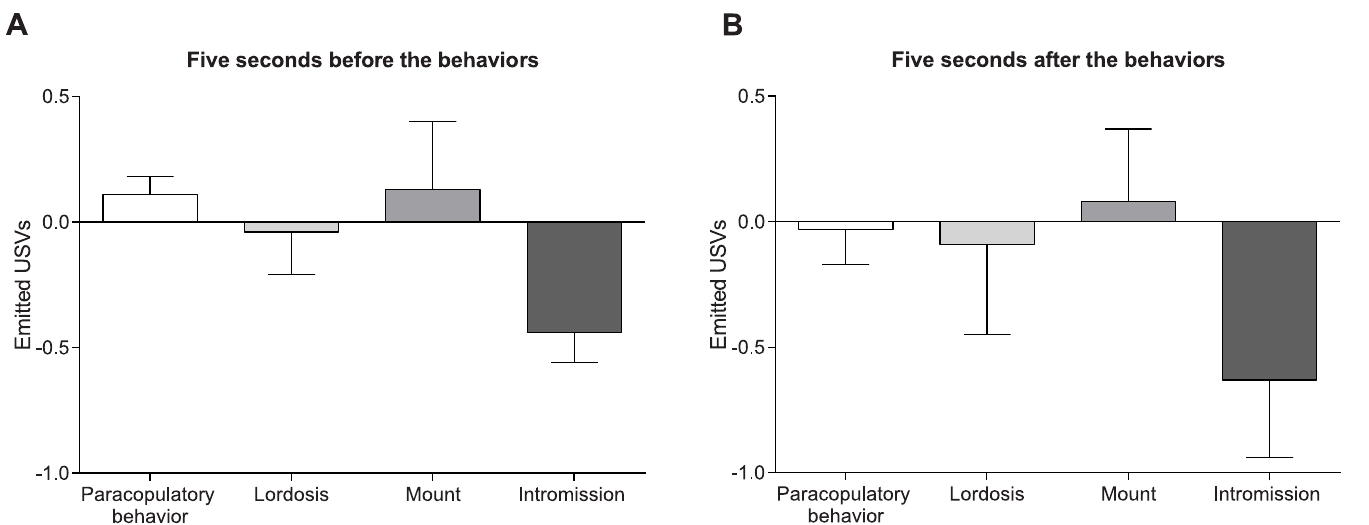
Fig 3. No changes in emission of female USVs before and after a behavior. (A) The average number of ultrasonic vocalizations (USVs) emitted by female rats (paired with devocalized males) during the five seconds before, and (B) the five seconds after a paracopulatory behavior, lordosis, mount, or intromission. Both graphs show the comparison between USVs emitted before or after the behaviors minus the USVs that would have been emitted during 5 seconds in the equally distributed USVs. Data are shown as median ± semi interquartile range.